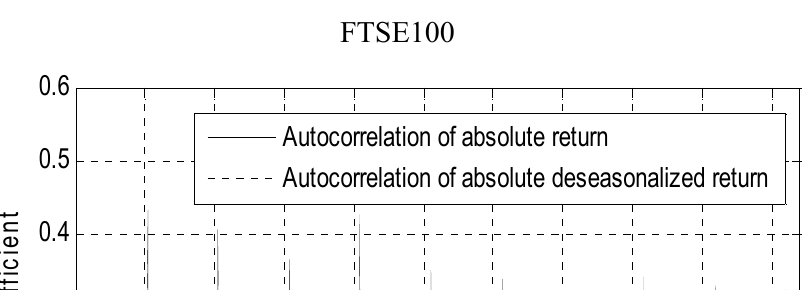
Autocorrelation of absolute return Autocorrelation of absolute deseasonalized